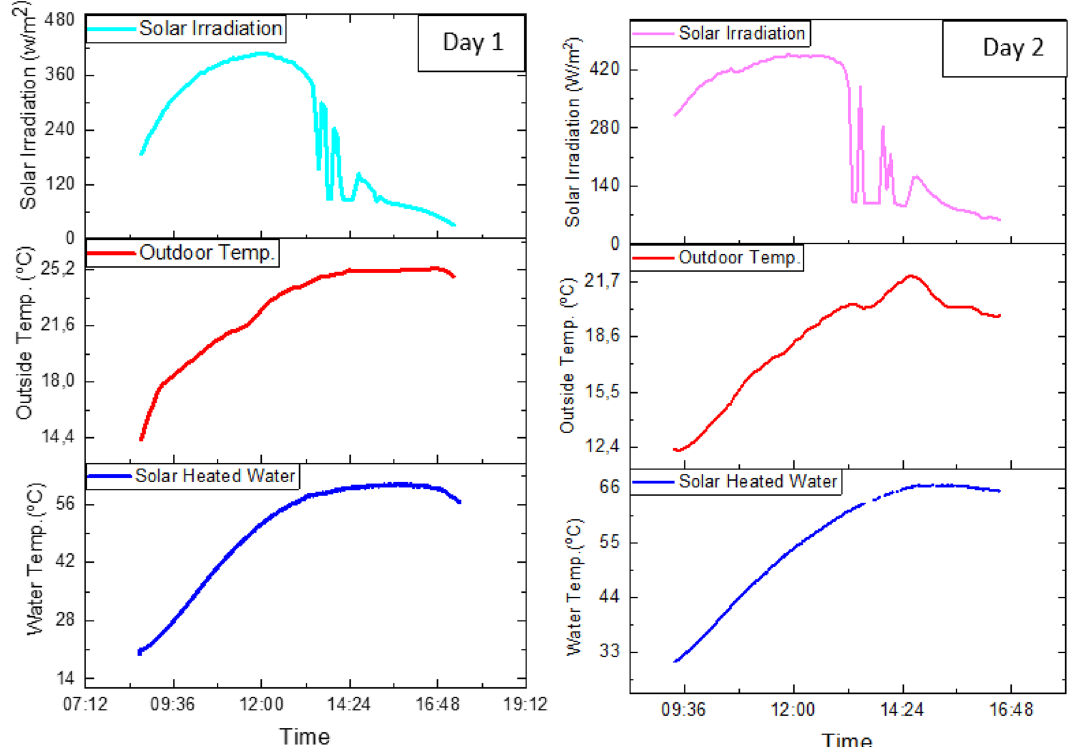
Fig. 4 Solar irradiation, outdoor temperature and solar heated water temperature for day 1 and day